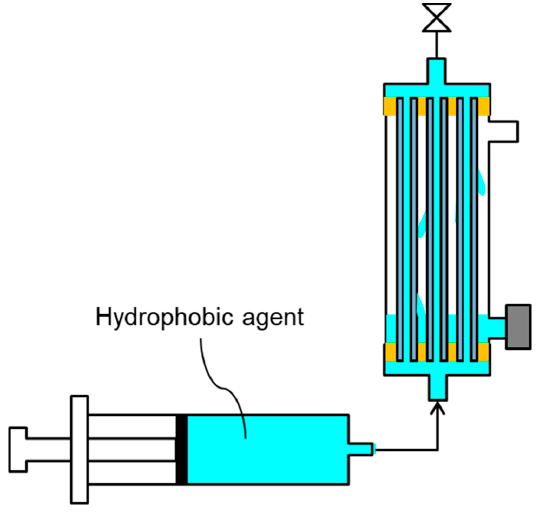
Figure 3. Schematic diagram of hydrophobic treatment.